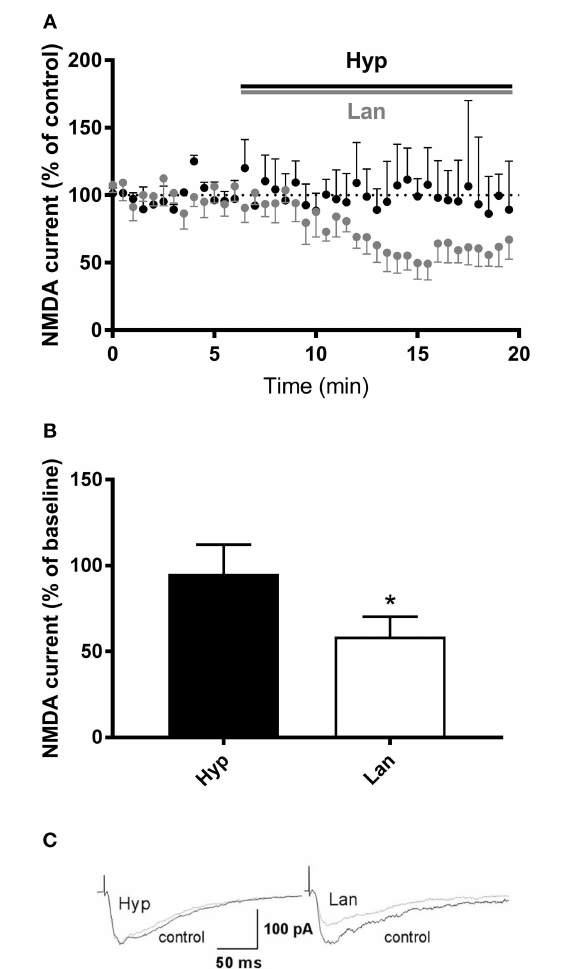
FIGURE 6 | Effects of hyperforin/Lanicemine on layer V to later II/III NMDA synaptic transmission. (A,B) Application of Lanicemine markedly reduced the NMDA current, whereas hyperforin had no effect ( p = 0.0313, median 51.63%, n = 6 vs. p = 0.8750, median 94.8, n = 4, respectively, Wilcoxon Signed Rank Test), * p < 0.05 vs. Hyp. Below, (C) Sample raw NMDA currents recorded under the two conditions, dotted line is for baseline